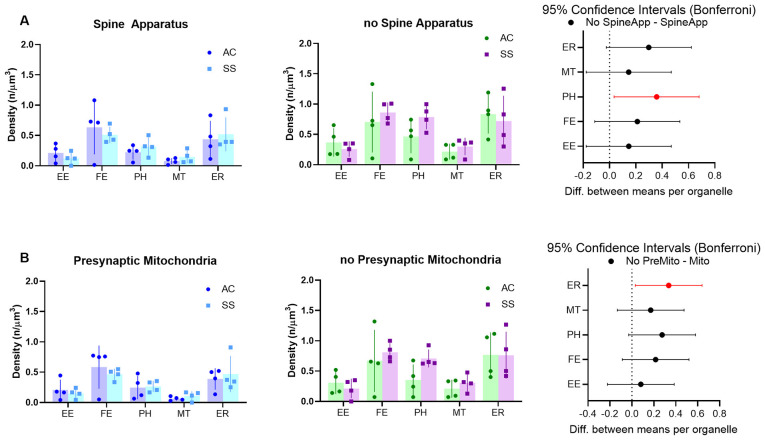
(A) Subcellular organelle distribution in PAPs surrounding synapses with (left) or without (middle) spine apparatus and relative statistical analysis (right, rmANOVA followed by post hoc Bonferroni tests, n = 4). (B) Subcellular organelle distribution in PAPs surrounding synapses with (left) or without (middle) presynaptic mitochondrion and relative statistical analysis (right, rmANOVA followed by post hoc Bonferroni tests n = 4). Empty endosomes (EE), full endosomes (FE), phagosome (PH), mitochondria (MT), and ER cisternae (ER) for all panels.